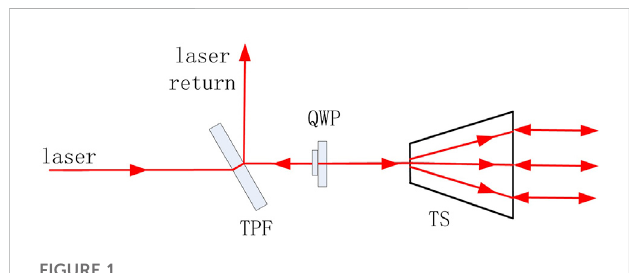
FIGURE 1 Schematic representation of a polarized coaxial generator for SLR.